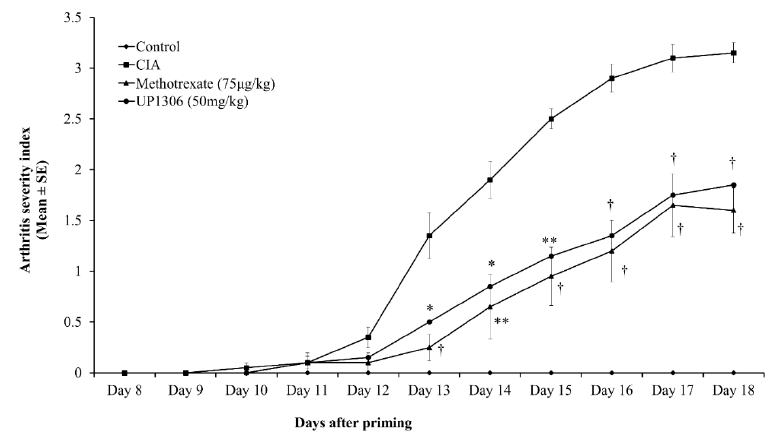
Figure 1. Changes of Arthritis severity index: Rats ( n = 10/group) were orally treated with UP1306 (50 mg/kg) and Methotrexate (75 µ g/kg) daily for three weeks post model induction. Score 0: No sign of grossly visible arthritis (Normal); 1: Swelling and/or redness of one or two interphalangeal joints (or mild swelling and erythema of digits or ankles); 2: Involvements of three to four interphalangeal joints (or moderate swelling and erythema of digits or ankles); 3: Swelling of entire paw (or marked swelling of paws including digits); 4: Deformity and ankylosis (or sever swelling and erythema with limited motion in many joints). Data are mean ± SE. * p ≤ 0.05; ** p ≤ 0.001; † p ≤ 0.0001 vs. Table 1. Area under treatment curve for collagen ‐ induced a rthriti s (CIA) rats treated with UP1306 and Methotrexate.